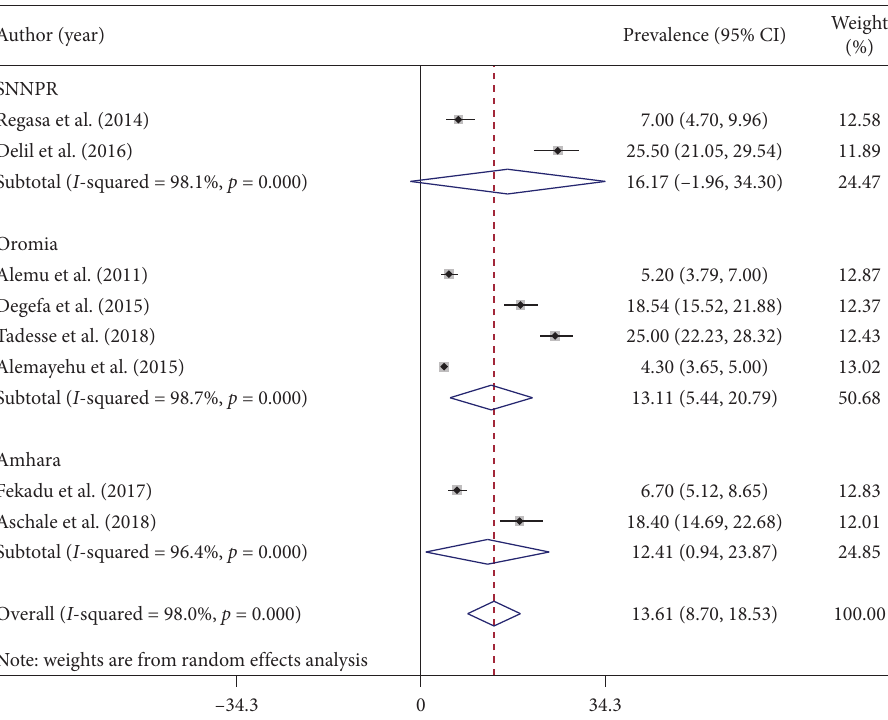
Figure 2: Forest plot showing the combined malaria pooled prevalence estimate among adults by regions of study in Ethiopia,